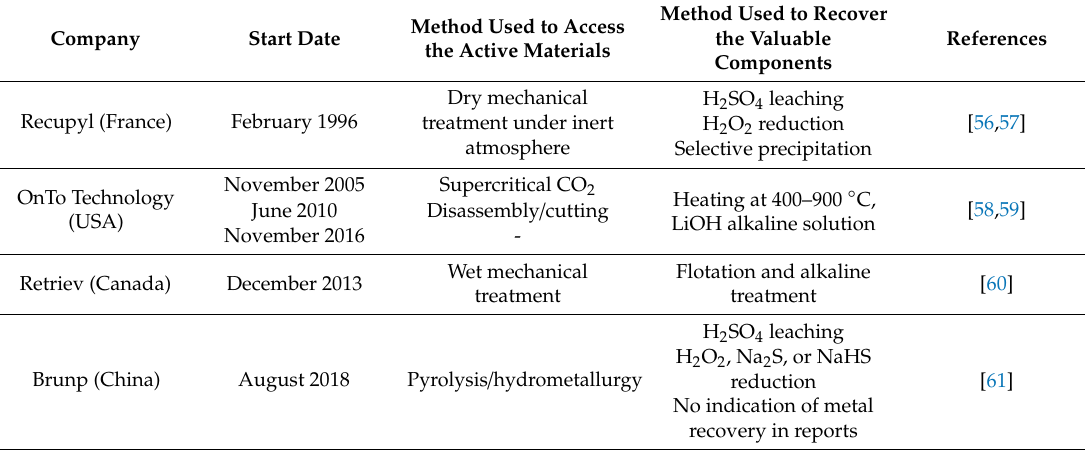
Table 4. List of current recycling operations: hydrometallurgical and direct